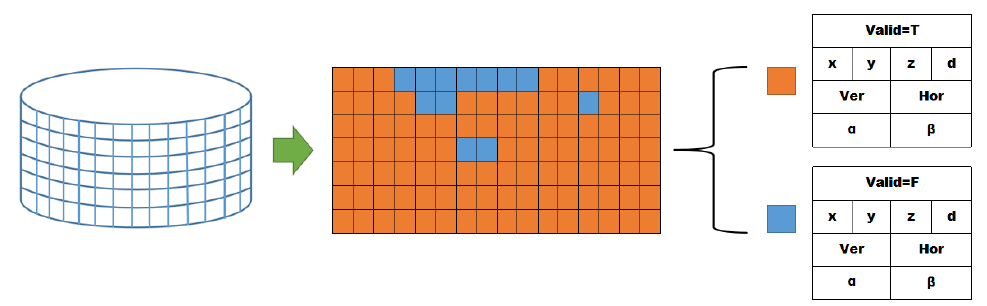
Figure 2. The range graph structure is similar to an unfolded cylindrical shape. After it is expanded, each node represents a single point. The nodes include valid nodes and invalid nodes. In the figure, orange represents valid nodes and blue represents invalid